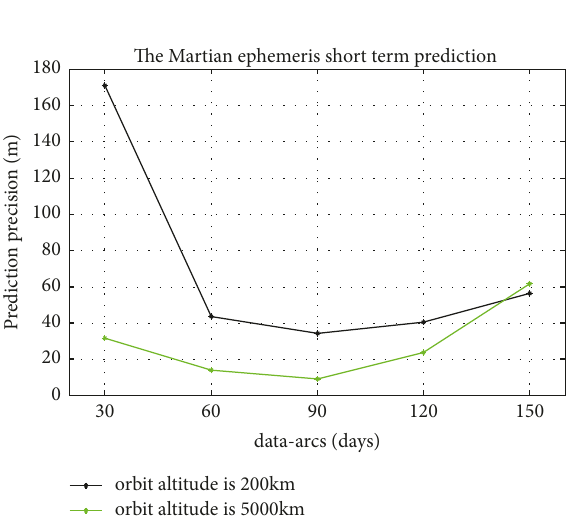
Figure 6: The Martian ephemeris short-term prediction with different probe orbit errors.